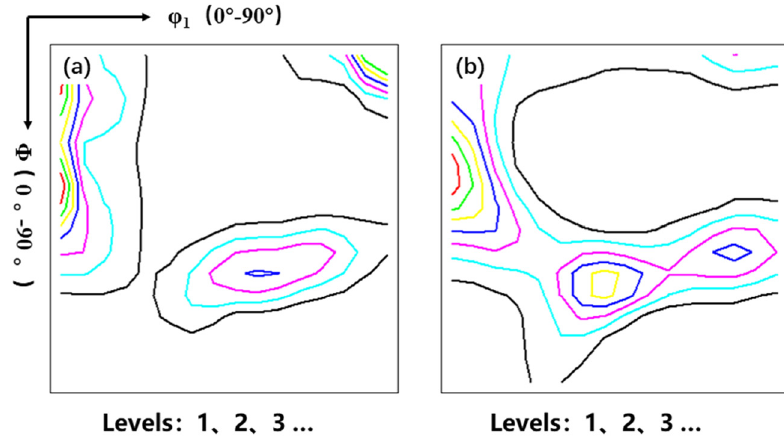
Figure 18: ODF diagrams of cold - rolled plates of two kinds of experimental steels at φ 2 = 45°: ( a ) Y - free and ( b ) Y - bearing.